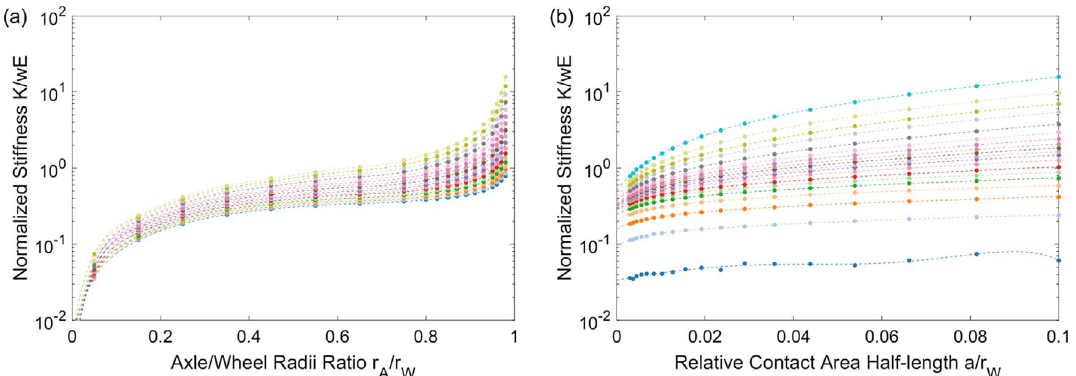
Figure 8. (a) Nineth order 1D polynomials for normalized wheel stiffness as a function of axle/wheel radii ratio. (b) Sixth order 1D polynomials for normalized wheel stiffness as a function of contact area half-length. Plotted on a logarithmic y -scale (base 10).